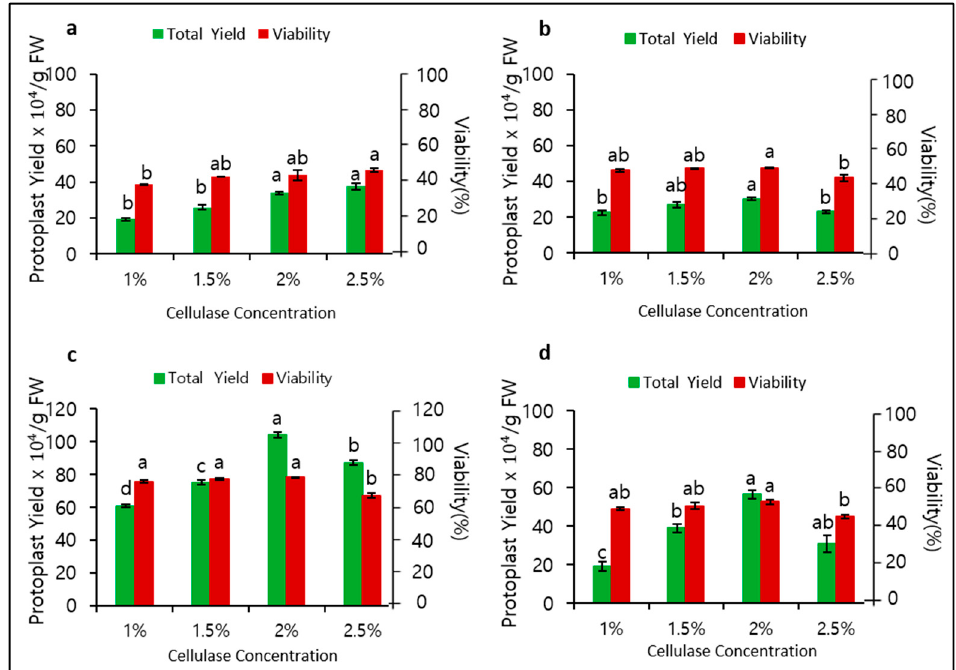
Figure 1. Effect of different mannitol and cellulase concentrations and 6 h digestion time on protoplast yield and viability: ( a ) 0.4, ( b ) 0.5, ( c ) 0.6, and ( d ) 0.7 M mannitol. Data represent the means of three replications. The bar indicates the standard deviation of three replications. Means with the same letters are not significantly different by Duncan’s multiple range test ( p < 0.05).